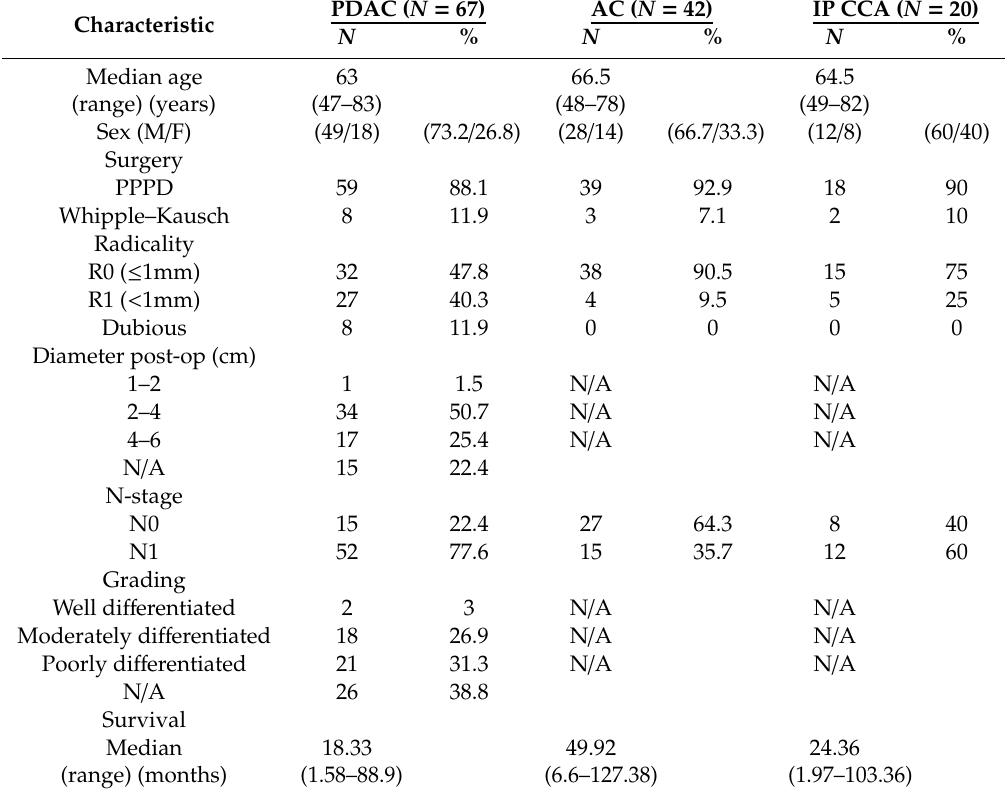
Table 2. Characteristics of patients included in the